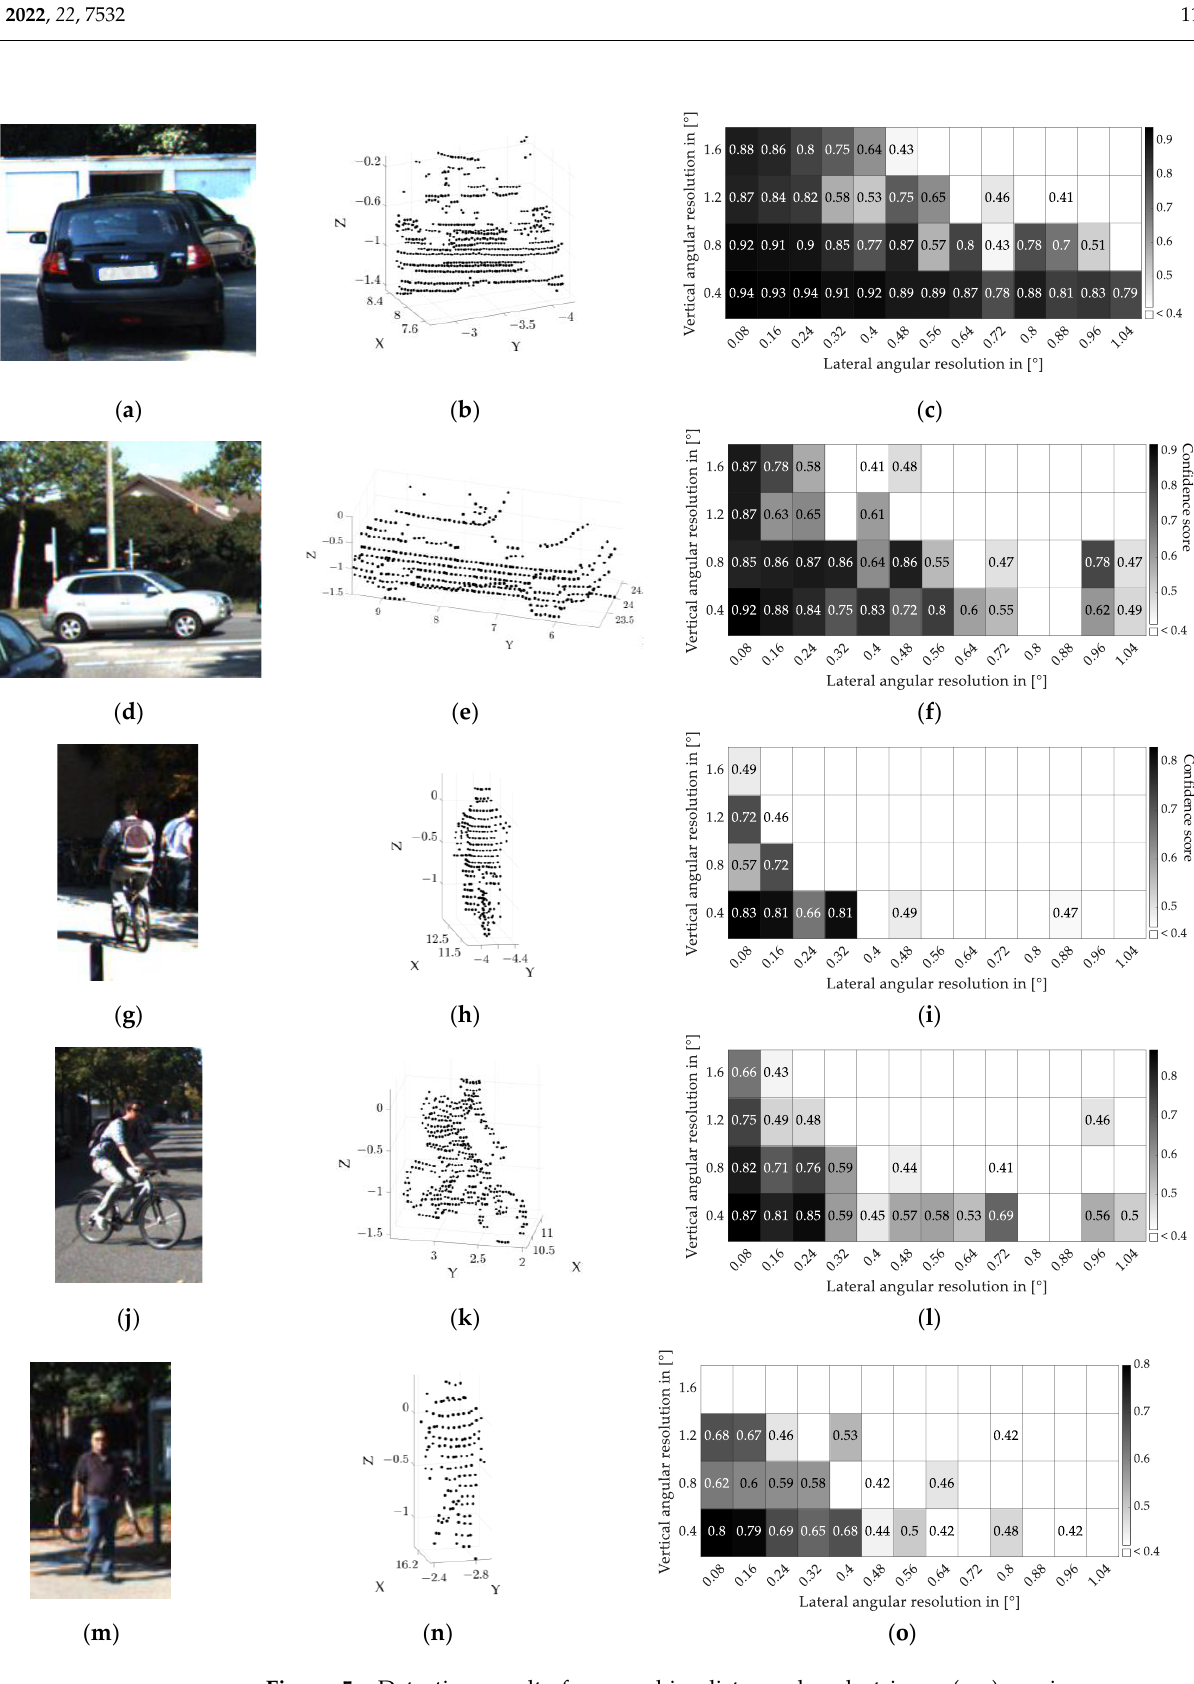
Figure 5. Detection results for cars, bicyclists, and pedestrians: ( a – c ) car in rear perspective; ( d – f ) car in lateral perspective; ( g – i ) bicyclist in rear perspective; ( j – l ) bicyblist in lateral perspective; ( m – o ) pedestrian. The left column shows RGB images of detection objects from the KITTI dataset [38]; the middle column shows raw point clouds of detection objects; and the right column shows the distribution of confidence scores varying with different angular resolutions.